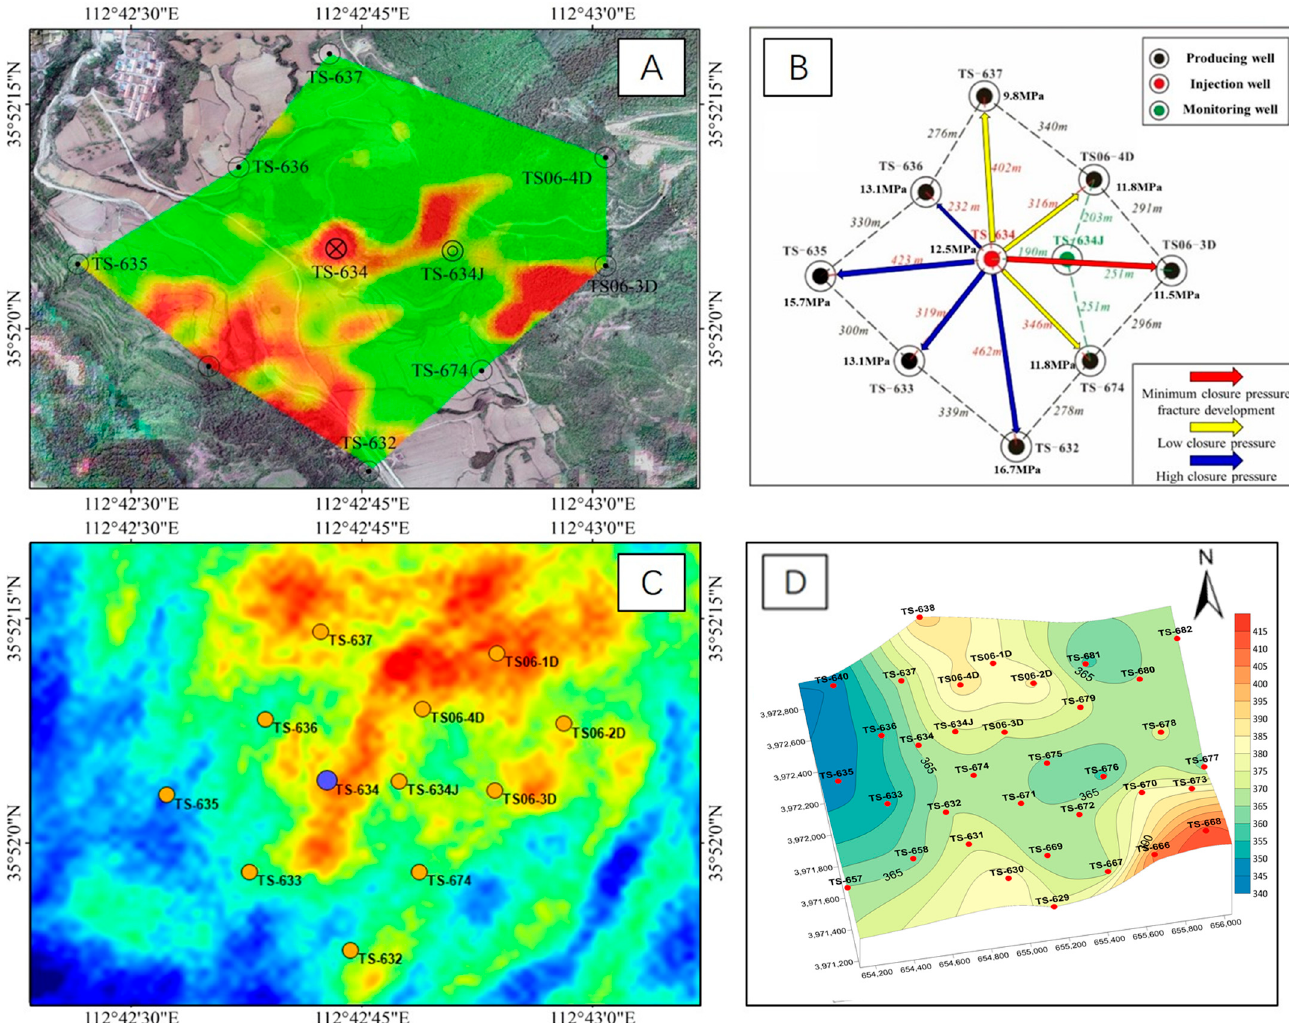
Figure 9. Comprehensive comparisons and verification graph of various methods. ( A ) Cumulative surface deformation derived by InSAR during CO 2 injection, ( B ) field stress distribution and bottom hole pressure for wells, ( C ) micro-seismic detection results during injection and ( D ) contour map of underground reservoir.